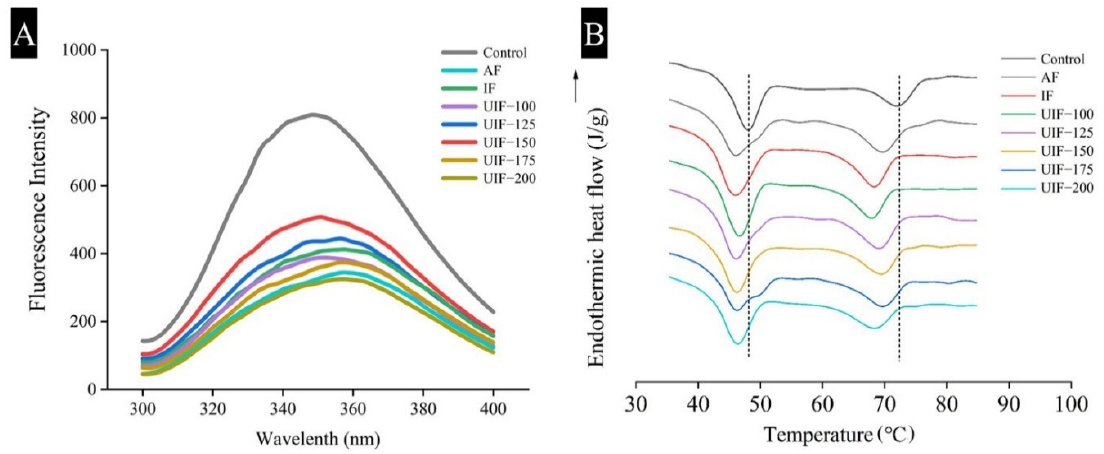
Figure 4. ( A ) Fluorescence images of myofibrillar proteins and ( B ) Thermal transition of control AMS and 90-day frozen stored AMS with different treatments. AF, air freezing; IF, immersion freezing; UIF, ultrasound-assisted immersion freezing at different ultrasound powers (100, 125, 150, 175, and 200 W).